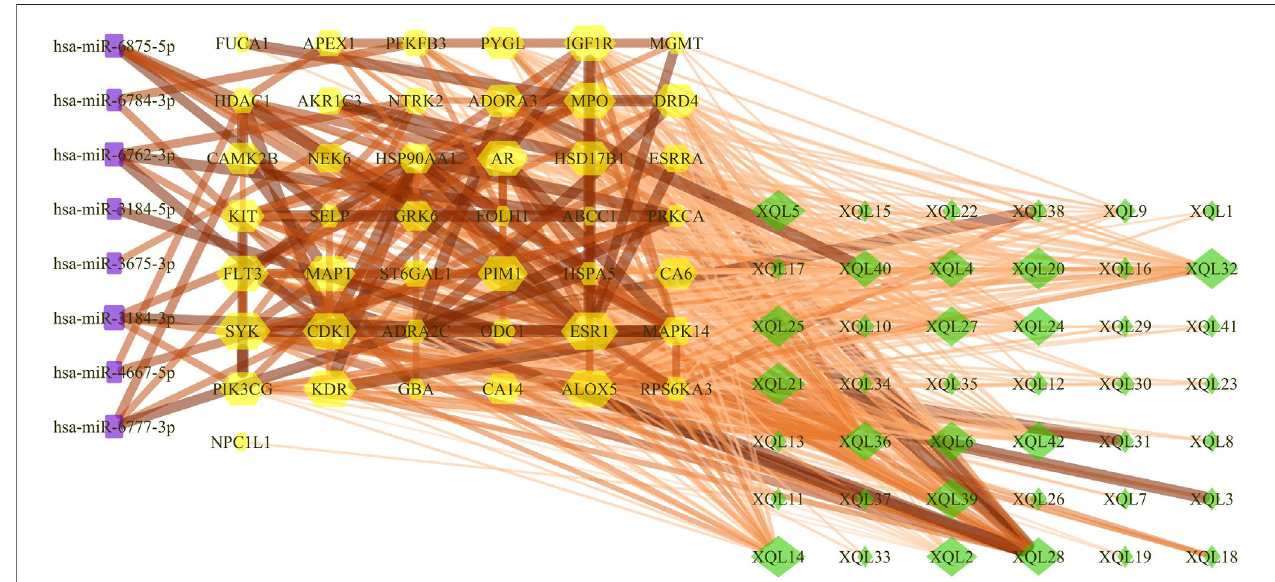
FIGURE 8 | Compound-target gene-miRNA (C-T-M) network. The purple rectangle represents the miRNAs, the yellow hexagon represents the targets, and the green diamond represents the fl avonoids of TFDM.